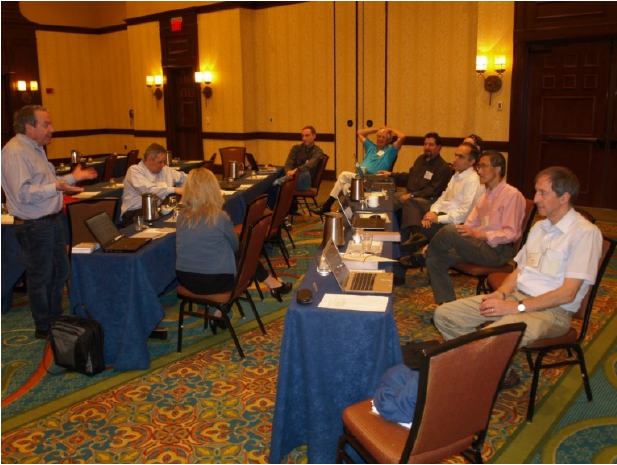
Figure 5. Participants in the comparative study of ECG measurements gather together in 2012 in Birmingham, Alabama anxiously listening to Dr. Paul Kligfield on the extreme left explaining the rules. He is being assisted by Dr. Cindy Green and Dr. Fabio Badilini. Representatives (from centre to right) from Mortara Inc, Philips, GE and Glasgow make up the remainder of those present.